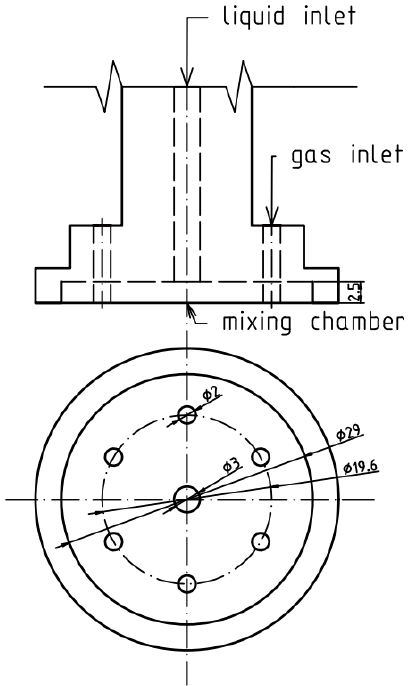
Fig. 3. Body of the counterflow atomizer